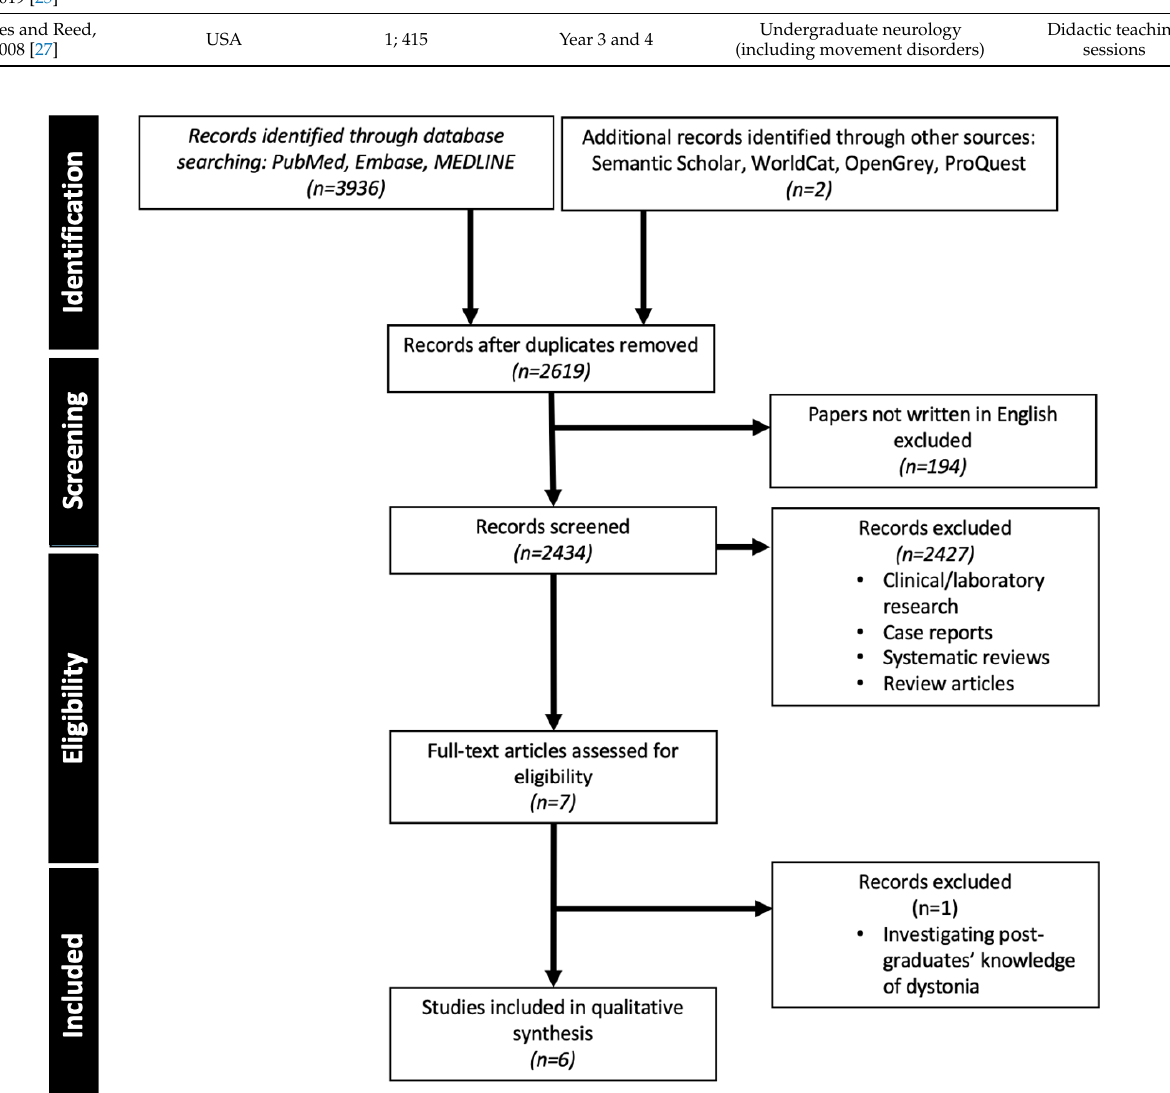
Figure 2. Preferred Reporting Items for Systematic reviews and Meta-Analyses (PRISMA) flow diagram illustrating literature search strategy.